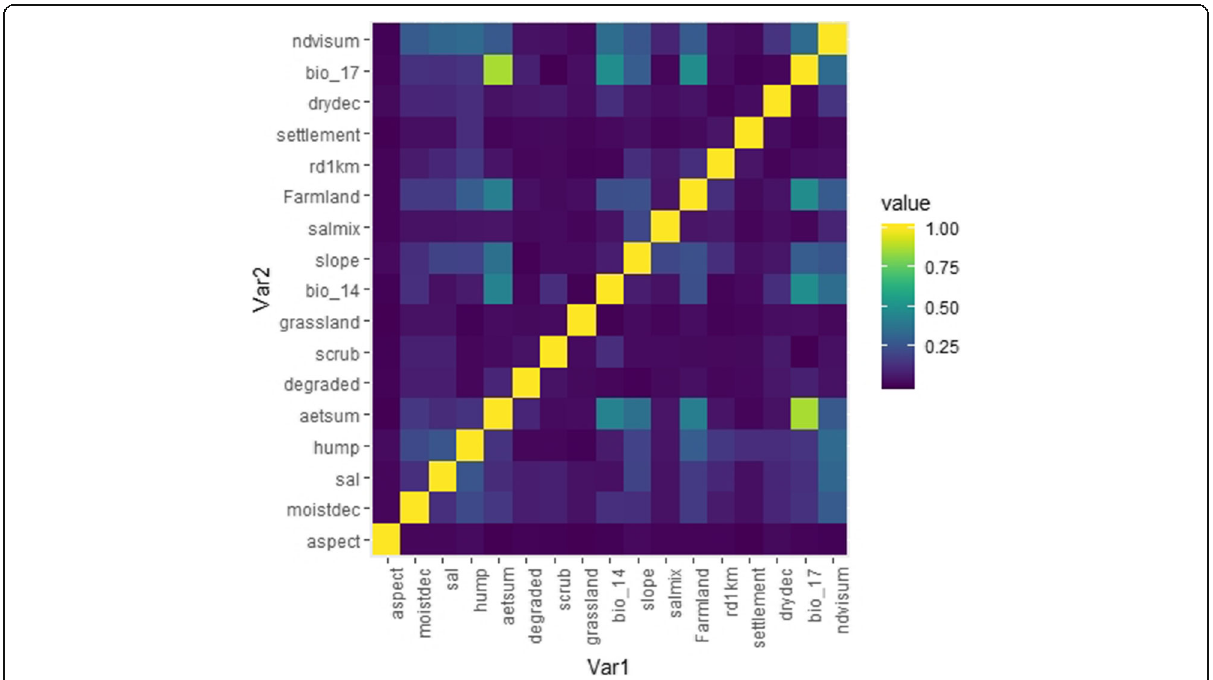
Fig. 2 Multi-colinearity among the predictor variables used in the final multi-scale habitat modeling of all four